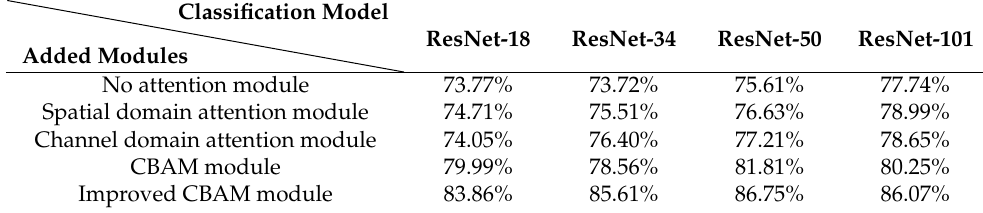
Table 9. F1 score of classification models under each attention mechanism.